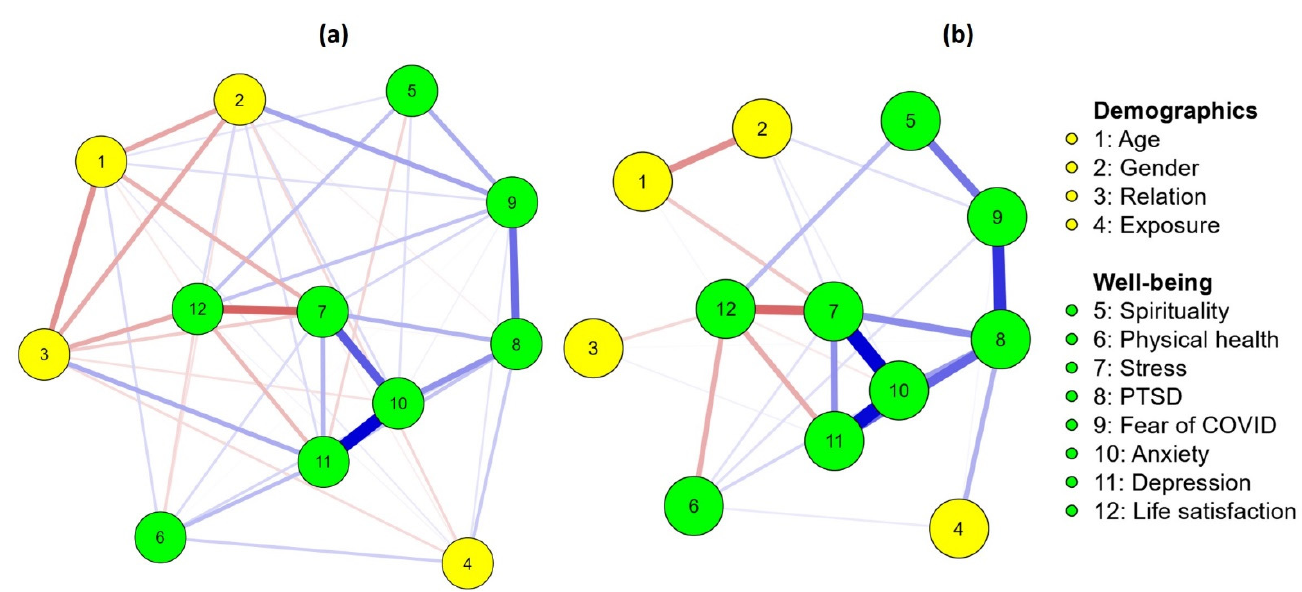
Figure 2. The network structure of demographics and well-being dimensions in the group of ( a ) vaccinated and ( b ) unvaccinated university students during the fourth wave of the COVID-19 pandemic. Red lines represent negative associations, while blue lines represent positive relationships. Line thickness represents the strength of the links. Relation = relationship status; PTSD = coronavirus-related post-traumatic stress disorder. N = 706.